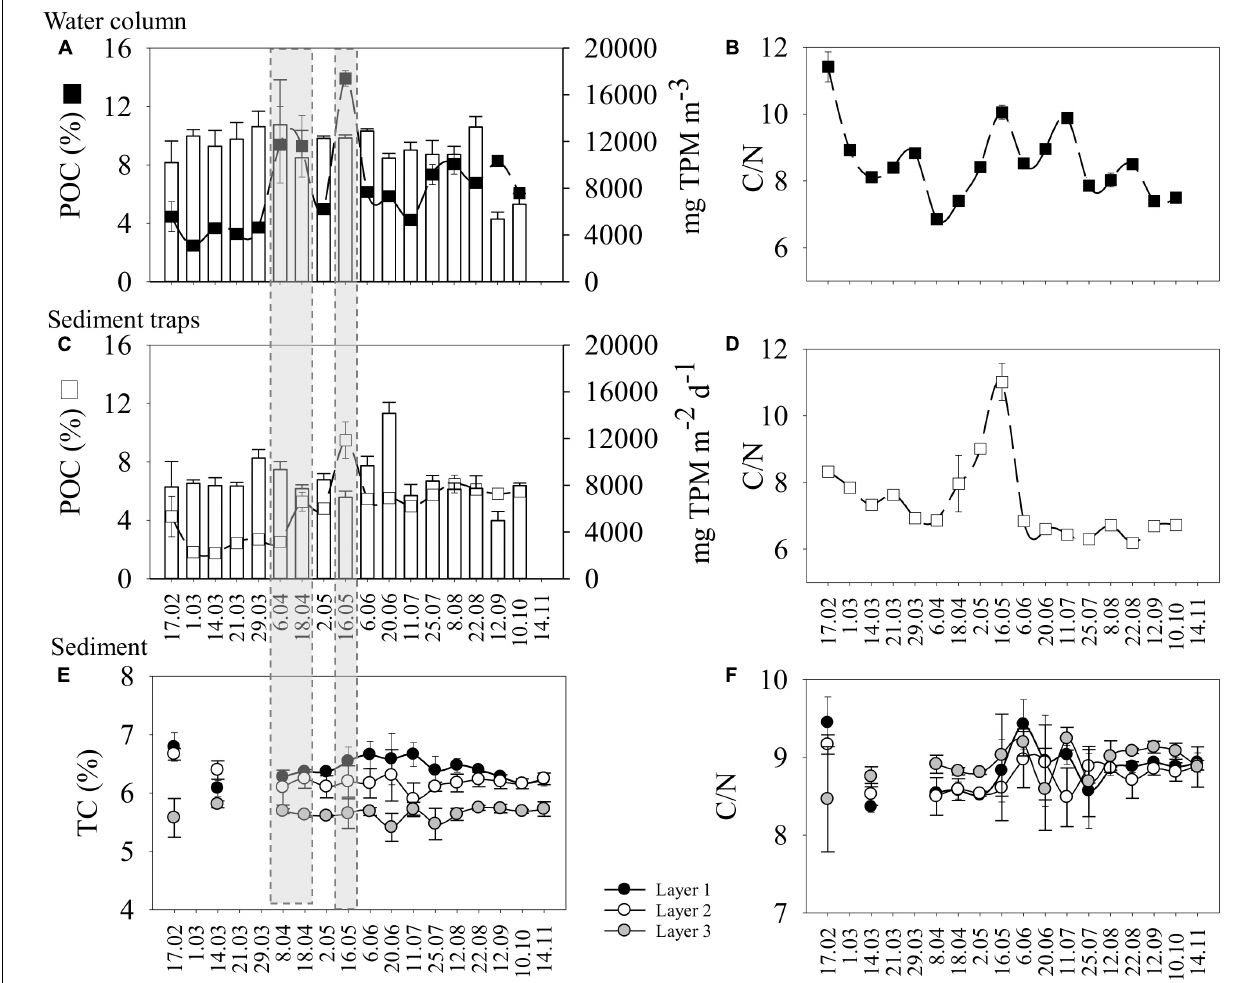
FIGURE 2 | Temporal variation (from February to November 2016) of the particulate organic carbon content (% of the total particulate matter, TPM), and the molar C/N ratio in the water column (A,B) and sediment traps (C,D) , and total carbon (%) and the molar C/N ratio from the seafloor sediment layers (E,F) . Additionally, sedimentation of TPM in the water column (A) and sediment traps (C) was bar-plotted. Mean values ± SD are shown. Note that for the water column and sediment traps most dates only have one replicate (see Supplementary Table S4 ), and samples were not taken in November